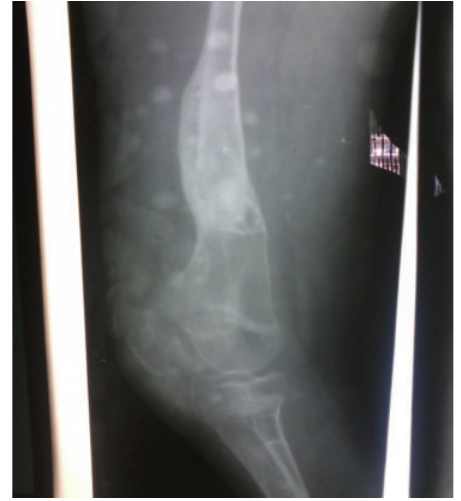
Figure 4: X-ray four and half months postoperative lateral view, showing fracture